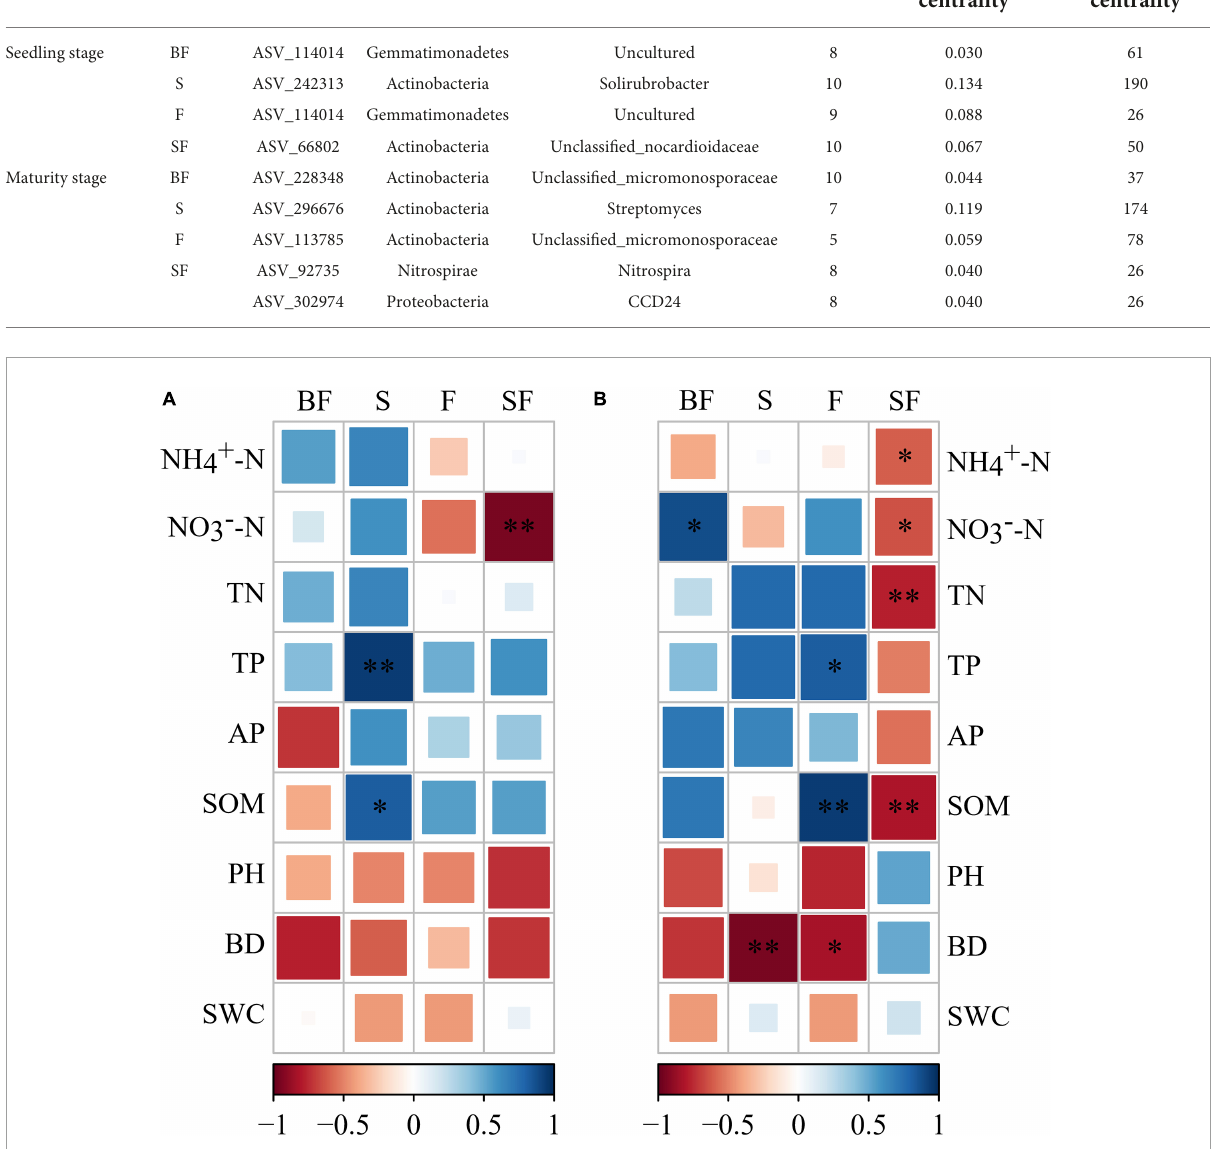
FIGURE9 Correlation between keystone taxa and soil physicochemical properties under different treatments. (A) Seedling stage, (B) maturity stage. The darker the color, the stronger the correlation. BF, S, F and SF stand for: straw biochar with fertilizer, straw, fertilizer, and straw with fertilizer, respectively. NH 4 + -N, ammonium; NO 3 − -N, nitrate; TN, total nitrogen; TP, total phosphorus; AP, available phosphorus; SOM, soil organic matter; BD, bulk density; SWC, soil water content. ∗ p < 0.05, ∗∗ p <